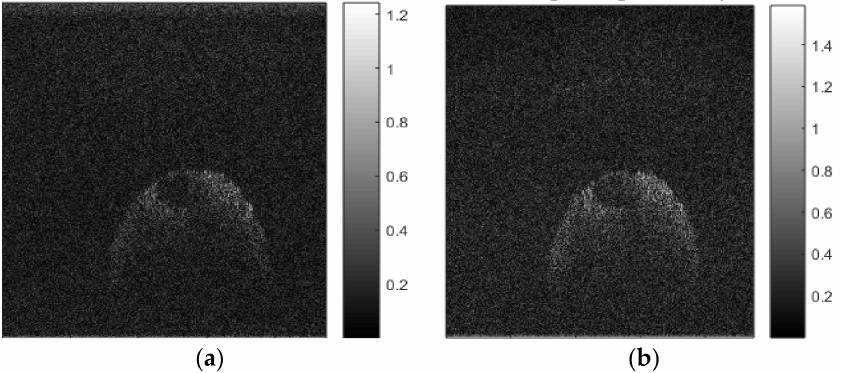
Figure 4. Reconstructed OCT image of a salamander egg using: ( a ) standard NDFT (without scaling); ( b ) our scaled